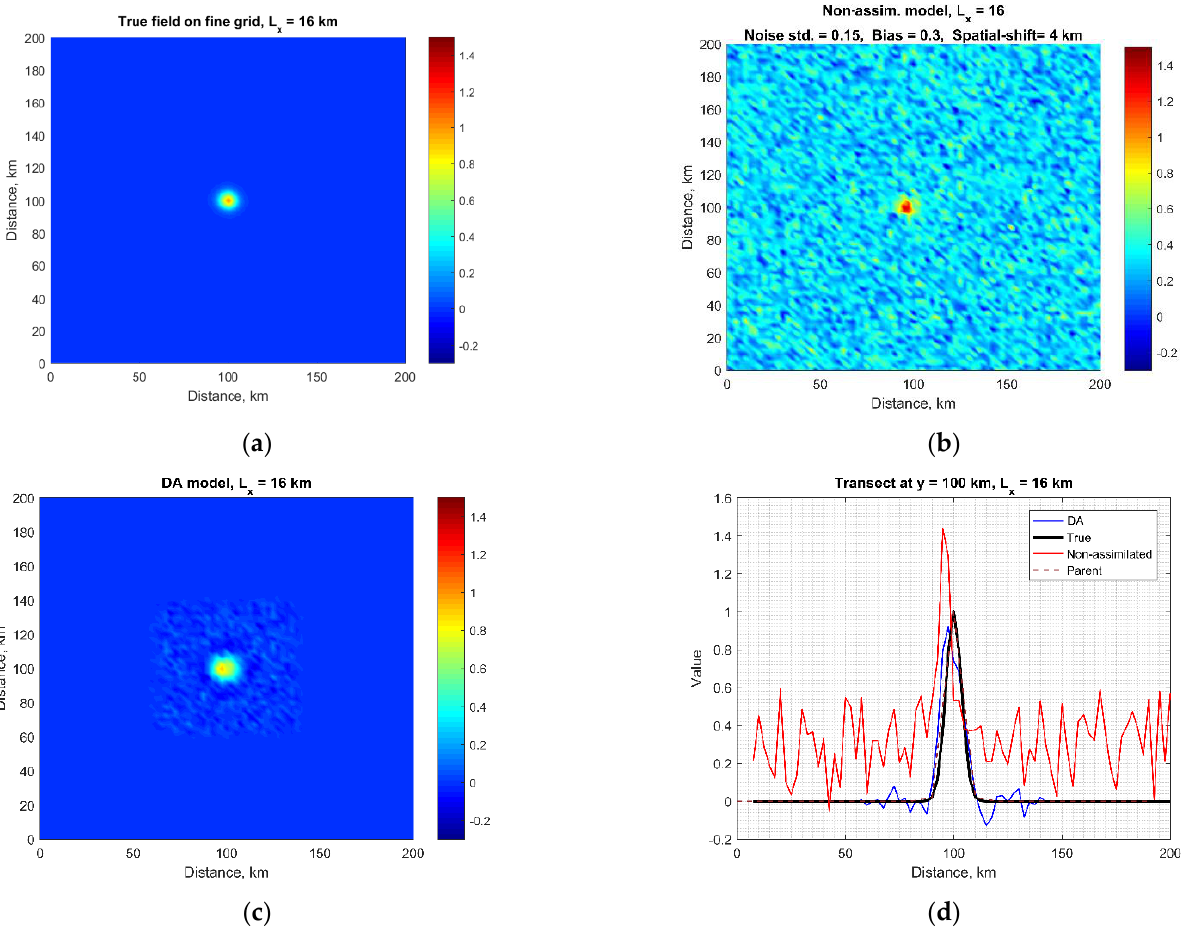
Figure 6. Results of NDA assimilation for a single isolated eddy: ( a ) true field sampled on the fine grid, ( b ) child model before data assimilation, ( c ) child model after NDA data assimilation, ( d ) transects showing the same fields as in ( a – c ) in comparison with the parent model. The NDA method reduces errors nearly to zero outside of the eddy and greatly reduces them inside the eddy (Figure 6b,d). The bias is reduced from 0.3 before data assimilation to 0.002 or less after assimilation. The reduction in RMSE for various values of eddy radius for the range 6 to 46 km is shown in Figure 7.